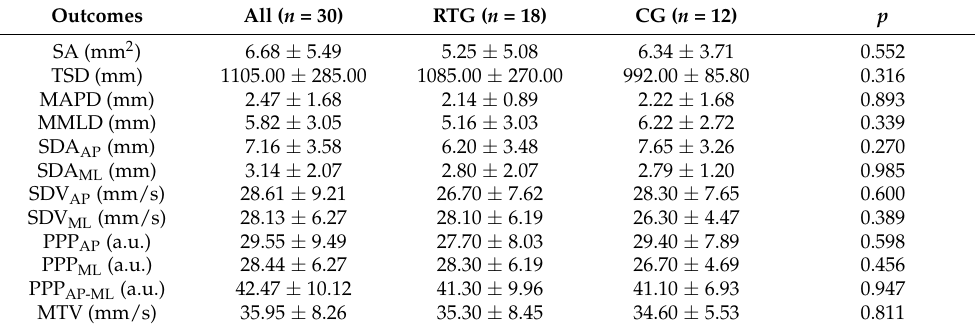
Table 3. Group comparisons of baseline measurements in eyes-closed balance